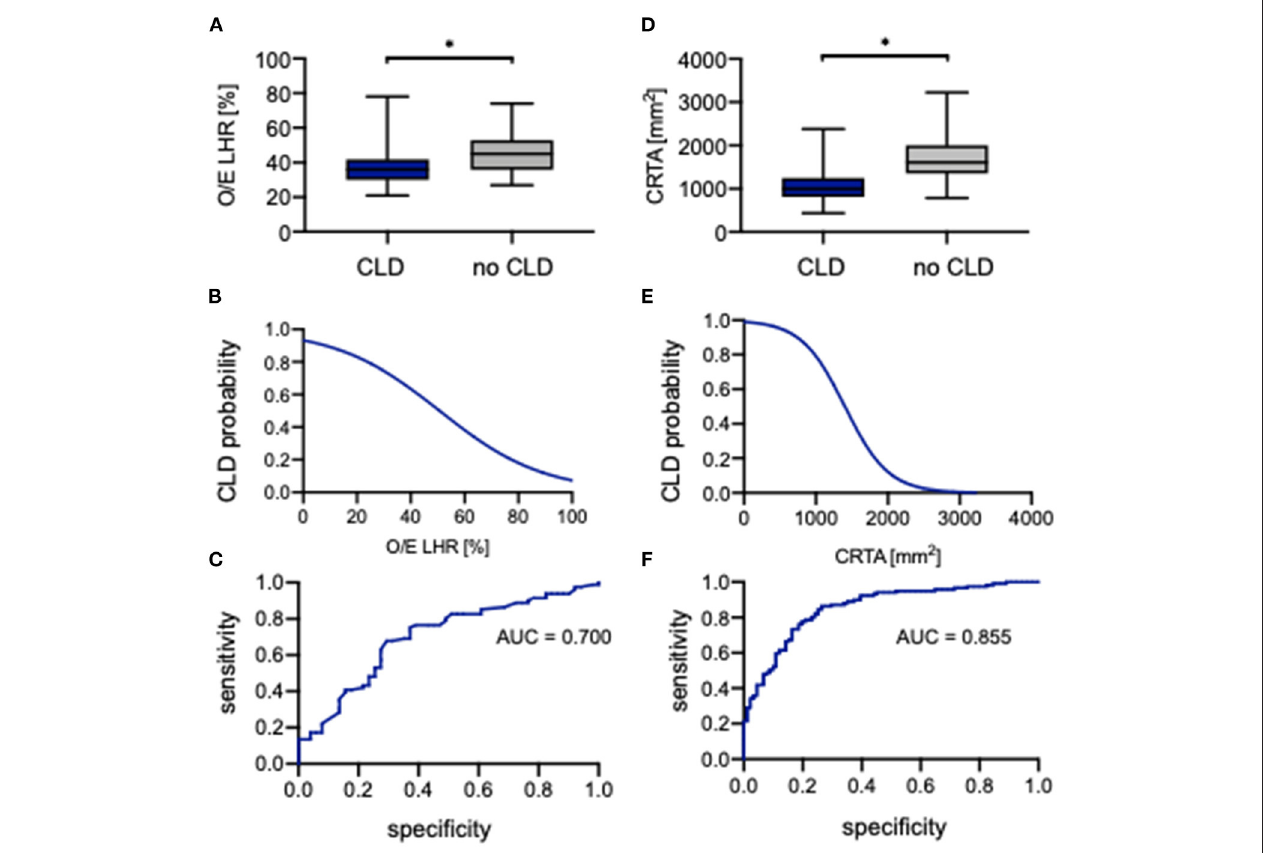
FIGURE 6 | Correlation of observed-to-expected lung-to-head ratio and CRTA to CLD. Boxplots of (A) observed-to-expected lung-to-head ratio and (D) CRTA are exhibited for patients with CLD and without CLD (whiskers are shown as minimum and maximum). Also shown is the logistical regression (B,E) and ROC curve (C,F) of observed-to-expected lung-to-head ratio and CRTA for the prediction of CLD probability in the study population. *represents a significant difference in the U test. AUC, area under curve; CLD, chronic lung disease; CRTA, chest radiographic thoracic area; LHR, lung-to-head ratio; O/E,